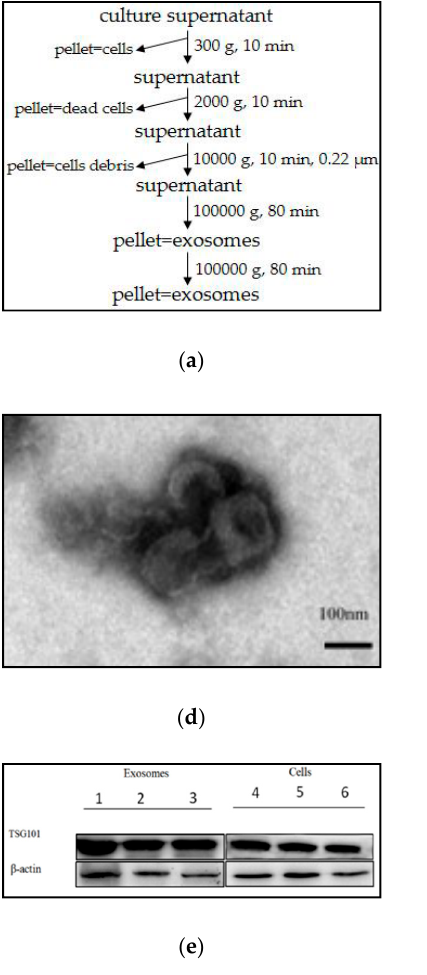
Figure 1. Exosomes isolation and characterization. ( a ) The isolation method of the culture cell-derived exosomes; ( b ) DLS result showed the size of MCF7 cell-derived exosomes about 100 nm in mode; ( c ) and EC109 cell-derived exosomes about 120 nm; ( d ) TEM displayed the morphology and size of exosomes which were negatively stained; ( e ) Detection of TSG101 expression on cell derived exosomes (1–3) and its original cells (4–6), β -actin as control. Note: 1. MCF7-exosome; 2. M231-exosome; 3. HepG2-exosome; 4. MCF7 cell; 5. M231 cell; 6. HepG2 cell.